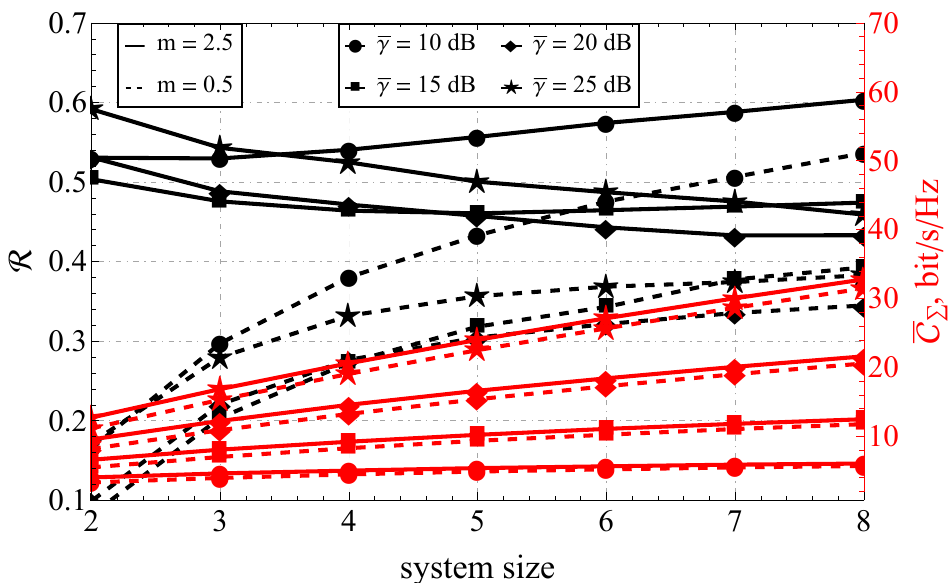
Figure 8. The joint R – C Σ performance of the variable-size MIMO system and different γ ’s. Comparing those results with the ones obtained for the intermediate number of antenna elements (see Figure 6), similar dependencies were observed (as for the 8 × 8 and 2 × 2 systems), but the effects were less pronounced. It is important to note that there was no extremum and the R – C Σ plots were